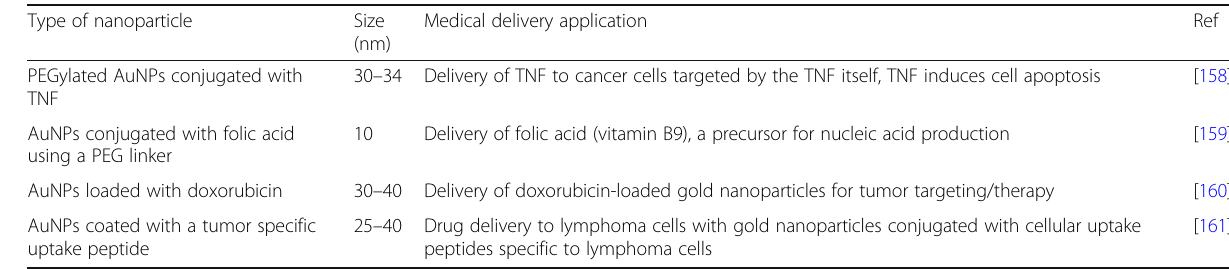
Table 5 A range of nanoparticle conjugates that have been examined for anticancer therapy Type of nanoparticle Size